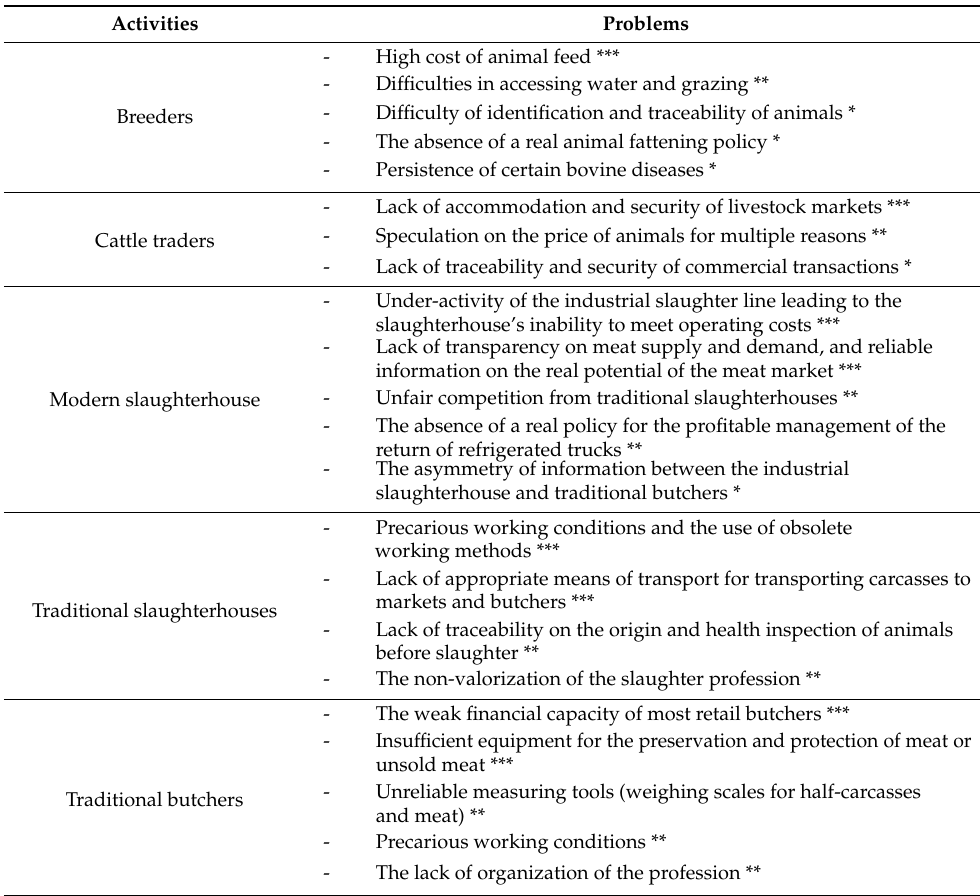
Table 5. Summary of the difficulties identified by the actors of the SC of meat (Single problem (*), important problem (**), critical problem